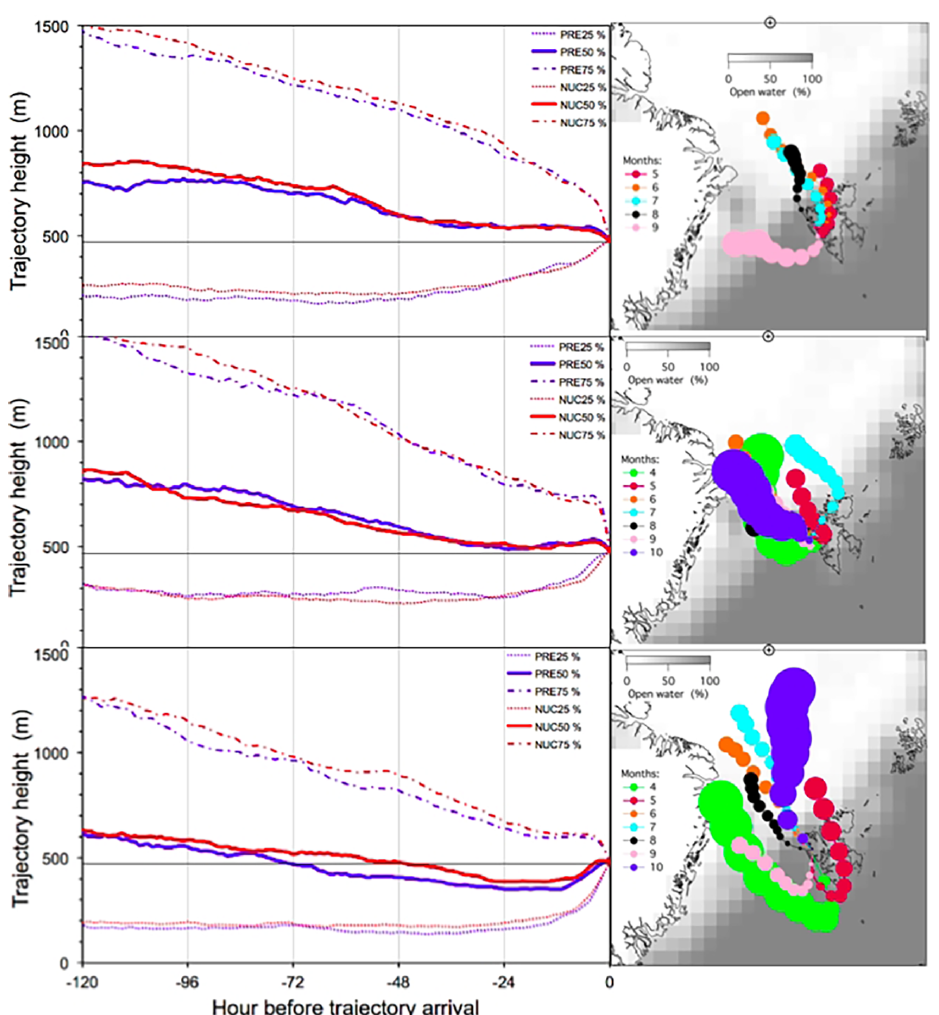
Figure 5. Left panels: median back-trajectory height profiles (m) during the 6 pre-event hours (full line in blue, PRENUC) and during the 9 DGR event hours (full line in red, NUC); 25 and 75% percentiles are shown as dotted and dash-dotted lines, respectively. Top: PCT events; center: DGR events; bottom: MEV events. The thin horizontal line marks the station level. Right panels: average monthly trajectory positions in 12h steps for the months April though October. Only months with at least 10 NPF events are shown. The circles comprise 95% of all trajectories at any trajectory step. The underlying grayscale map indicates July ice cover averaged over the years 2006–2015.